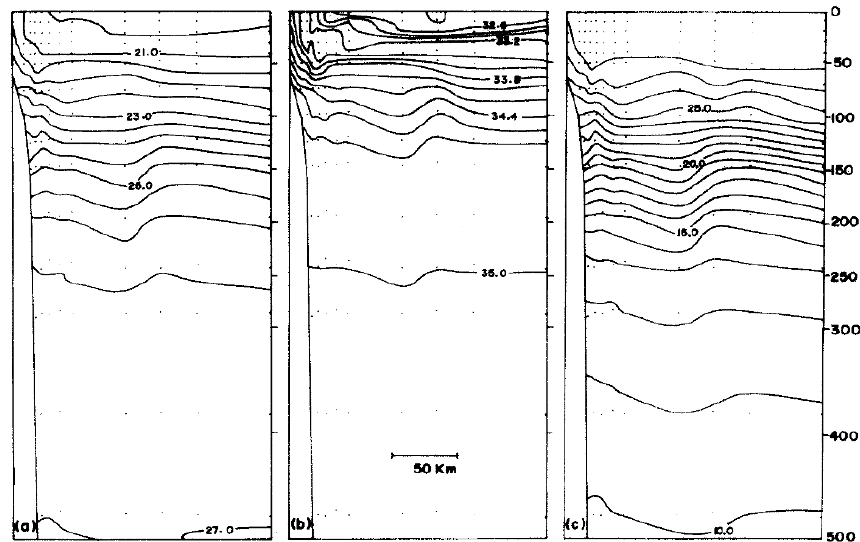
Figure 18. Hydrography along a section (normal to the coast) which lies approximately midway ( ∼ 15 N) along the east cost of India. (a) Potential density (gcm − 3 ) ; (b) salinity (ppt); (c) temperature ( ◦ C). The scale shown in (b) also applies to (a, c) (from Shetye et al.,